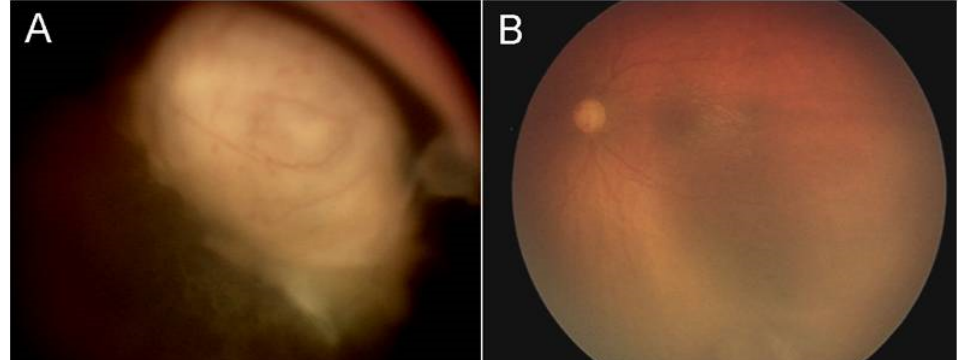
Figure 1: (A) A large vascular non-pigmented mass of the ciliary body, (B) optic nerve cupping and vascular attenuation are noted.